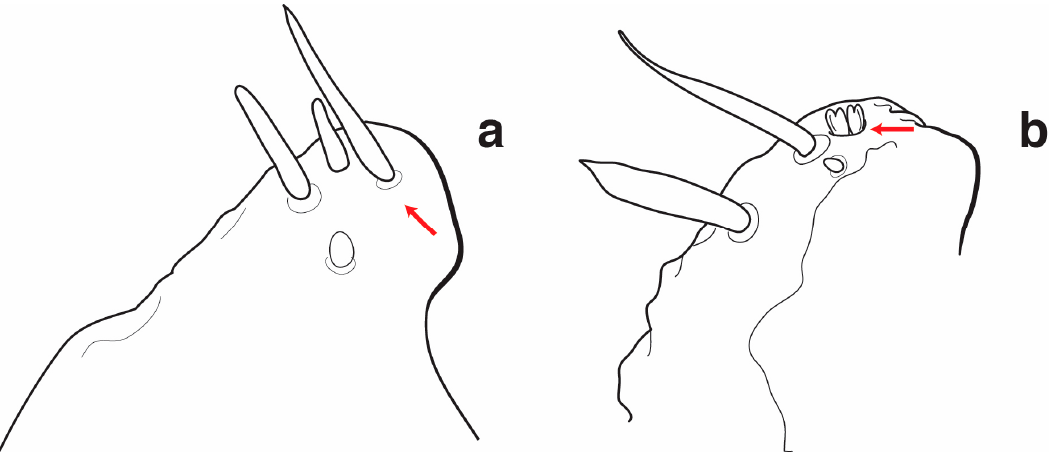
Figure 50. Mala, larva, ventral view: ( a ) Tryphetus ; and ( b ) Cyrtotrachelus .